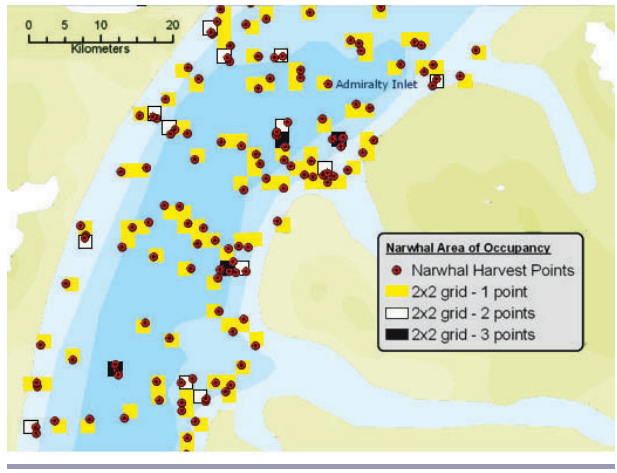
Fig. 4 . Area of occupancy (AO) illustration using 2x2 km grid cell applied to narwhal ( Monodon monoceros ) harvest